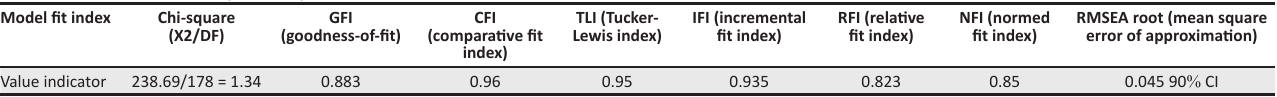
TABLE 3: Model fit indices for path analyses.